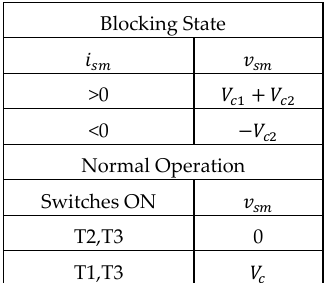
Figure 9. Figure 9. DCSM.